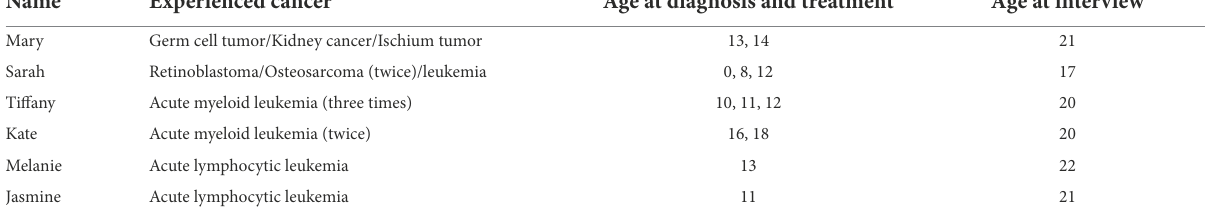
TABLE 2 Characteristics of participants.